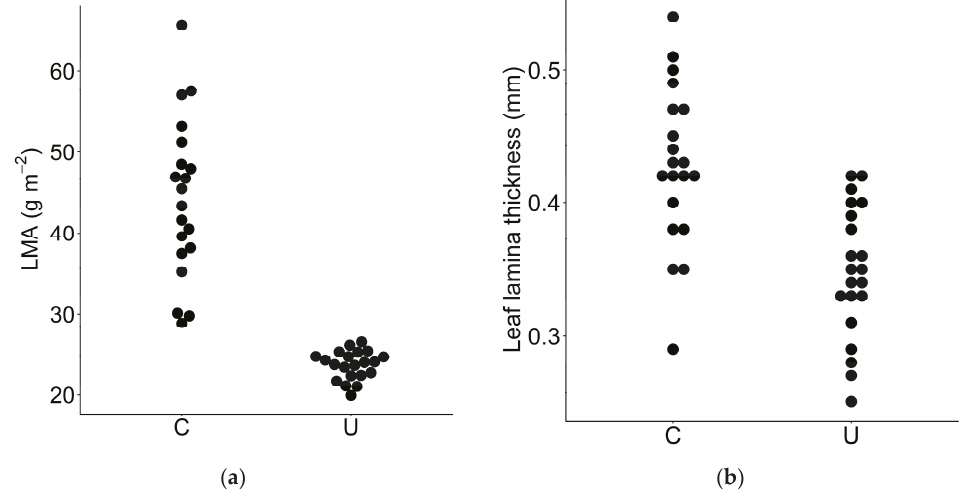
Figure 7. ( a ) Leaf mass per unit area (LMA) and ( b ) lamina thickness of the sun leaves in the clearing (C) and the shade leaves in the understory (U). Each closed circle indicates one leaf. The thicknesses were measured with a resolution of 0.01 mm.